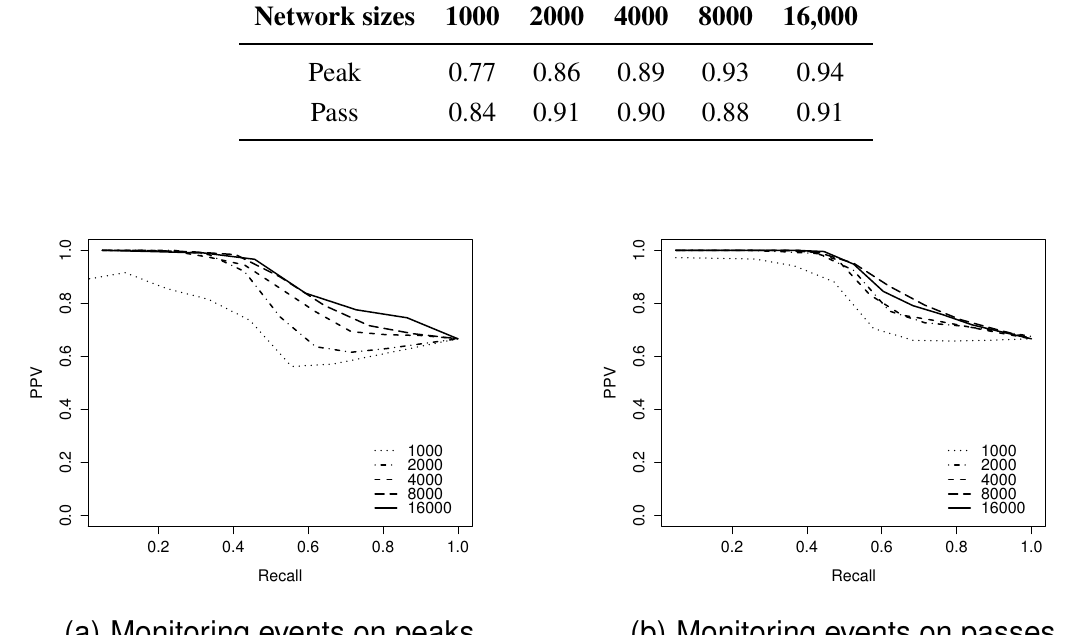
Table 1. F1-score for monitoring events occurring on peaks and passes on a Level 4 surface Network sizes